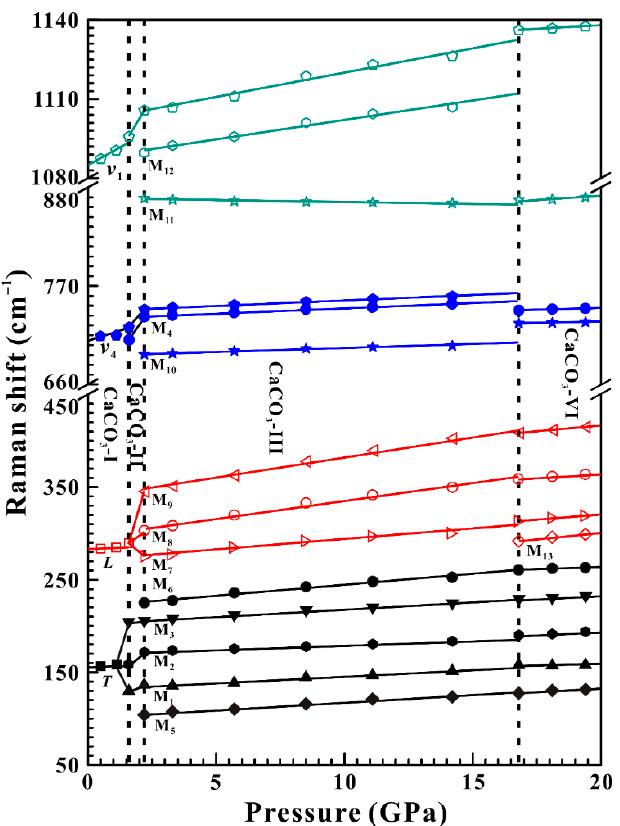
Figure 3. Pressure dependence of the Raman shifts of calcite upon compression within the wavenumber range of 100–1200 cm − 1 at the atmospheric temperature. The colored solid lines and the vertical black dashed lines are used to guide the eyes.